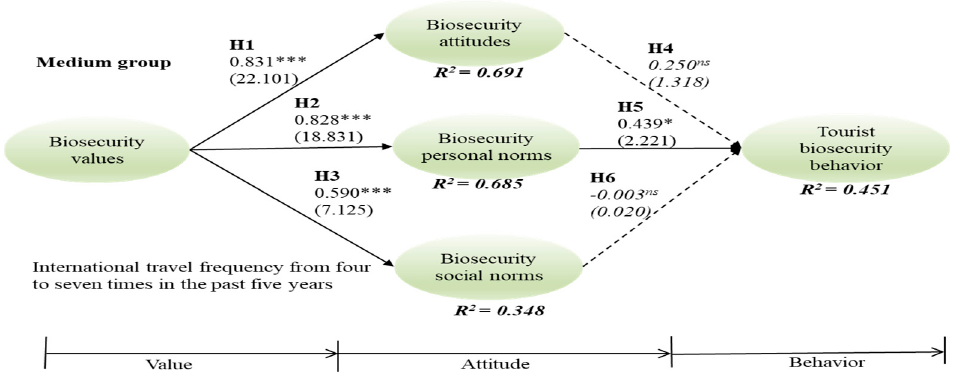
Figure 2. Medium group of international travel frequency. *** p < 0.001; * p < 0.5; ns = non-signifi-